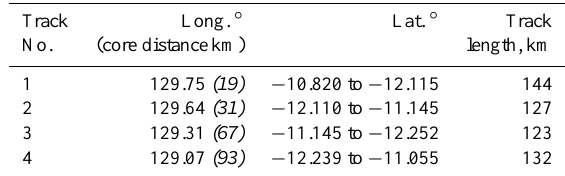
Table 1. Track Longitude, Latitude and Track